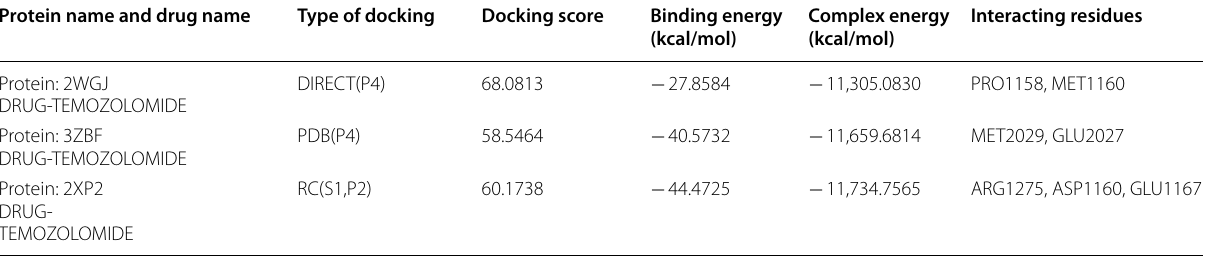
Table 8 Details of best-docked complexes of proteins with least energy and main hydrogen bond interaction showed amino acid residues on the binding sites Protein name and drug